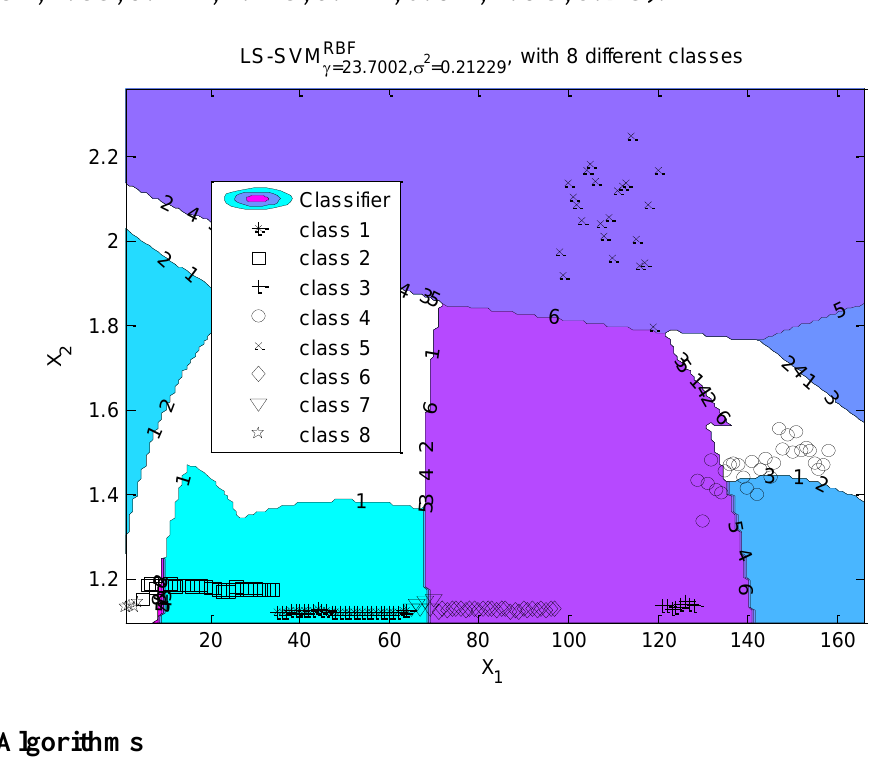
Figure 8. The projections of LS-SVM hyperlanes in the original feature